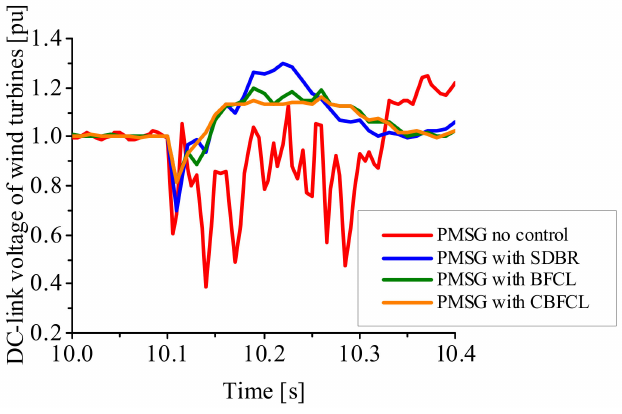
Figure 24. DC-link voltage of PMSG wind turbine.